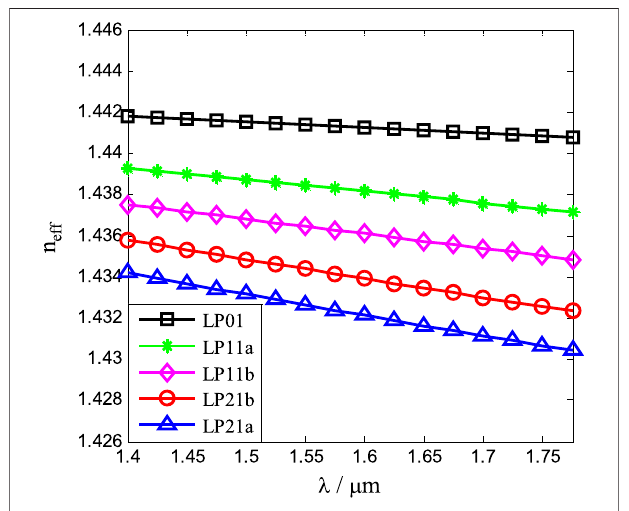
FIGURE 3 | Variations of the effective refractive indexes with the input light wavelength. The solid lines with squares, stars, diamonds, circles, and triangles represent the effective refractive indexes of the modes LP01, LP11a, LP11b, LP21b, and LP21a, respectively.